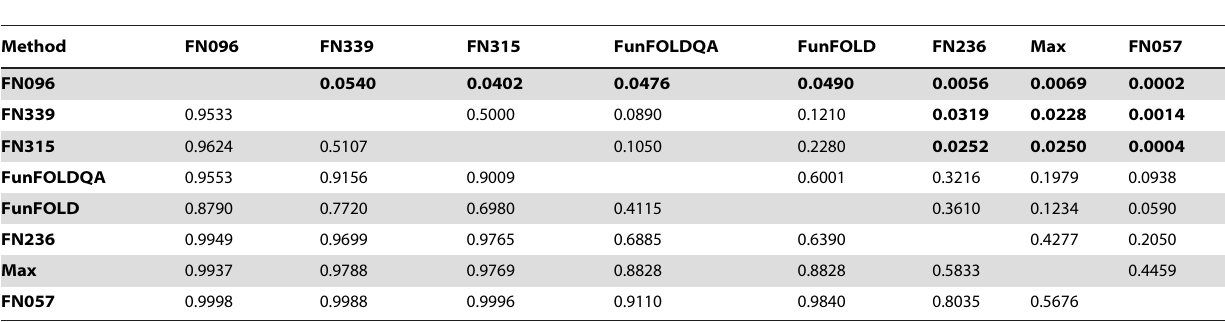
Table 5. All versus all analysis for the top server methods in CASP9 along with the FunFOLD and FunFOLDQA methods.